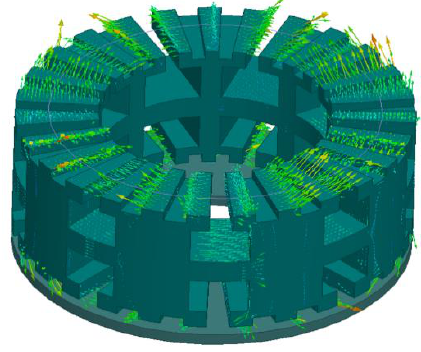
Figure 2. Flux density on the surface of one side of the stator.